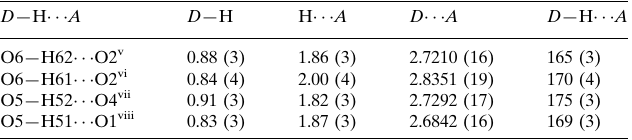
Hydrogen-bond geometry (A˚ , (cid:3)